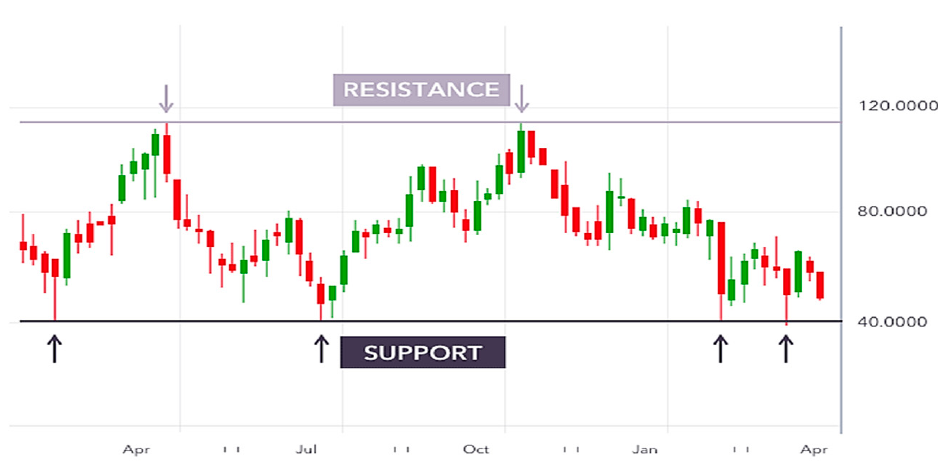
Figure 4. Support and resistance trading strategy.